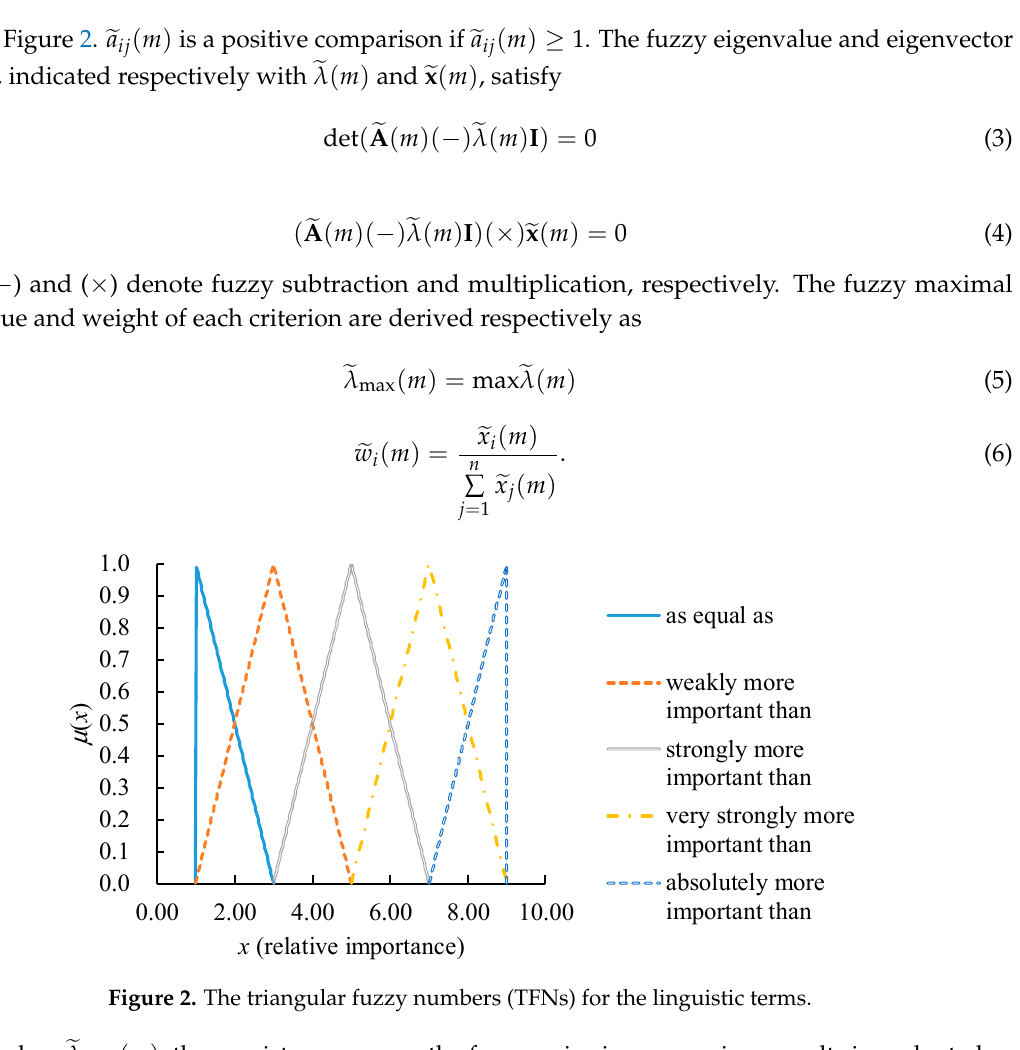
Figure 1. The procedure of the partial-consensus posterior-aggregation fuzzy analytic hierarchy process (PCPA-FAHP) approach.